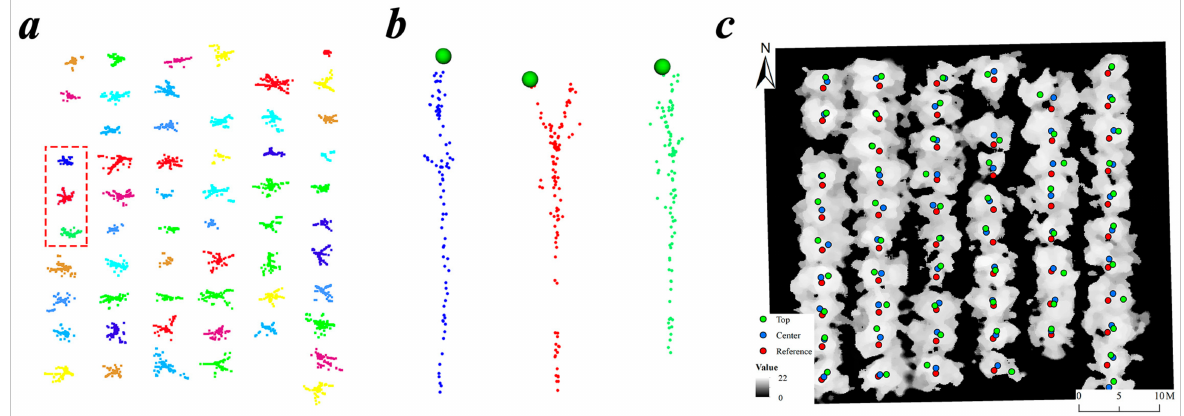
Figure 6. Illustration of the two types of seed points using plot Y8-1 as an example. ( a ) The cluster created by the Mean Shift algorithm based on the LiDAR data from the leaf-off season; ( b ) the treetops of each tree cluster from the red rectangle from ( a ); ( c ) the reference tree positions (red), the Mean Shift center points (blue), and the treetop points (green) in the data view of the leaf-on